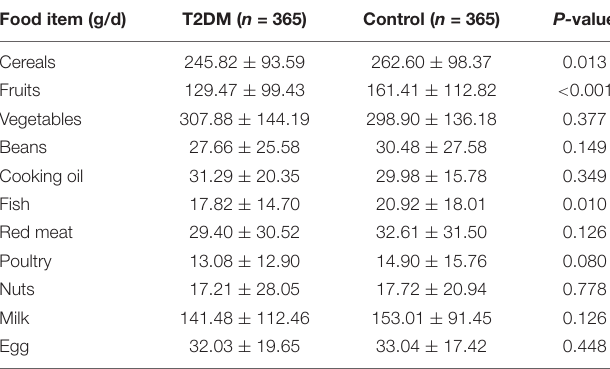
TABLE 2 | Daily food intake in subjects with type 2 diabetes mellitus (T2DM) and control subjects.